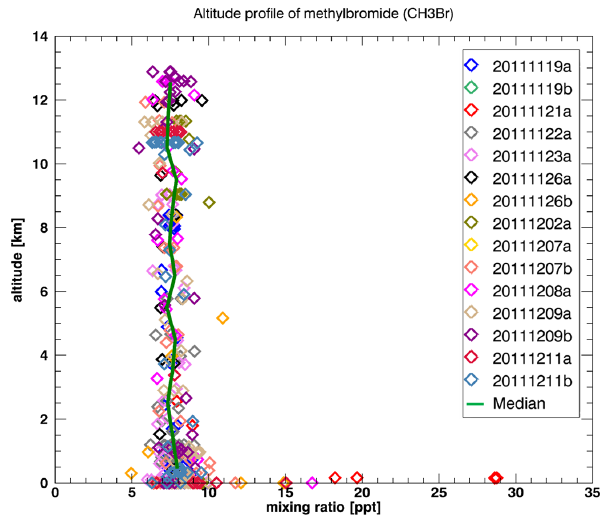
Figure 9. As Fig. 3, for CH 3